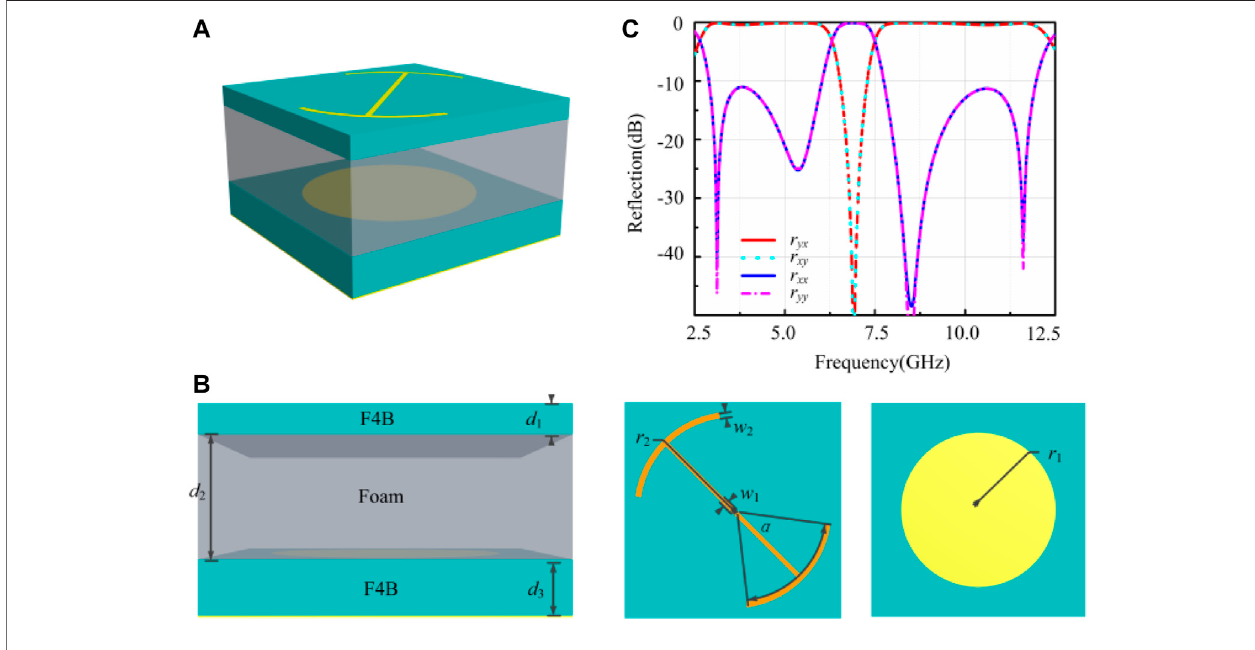
FIGURE 4 | (A) Perspective view of the meta-atom. (B) Diagram of the meta-atom. (C) Co- and cross-polarized re fl ection of the meta-atom.